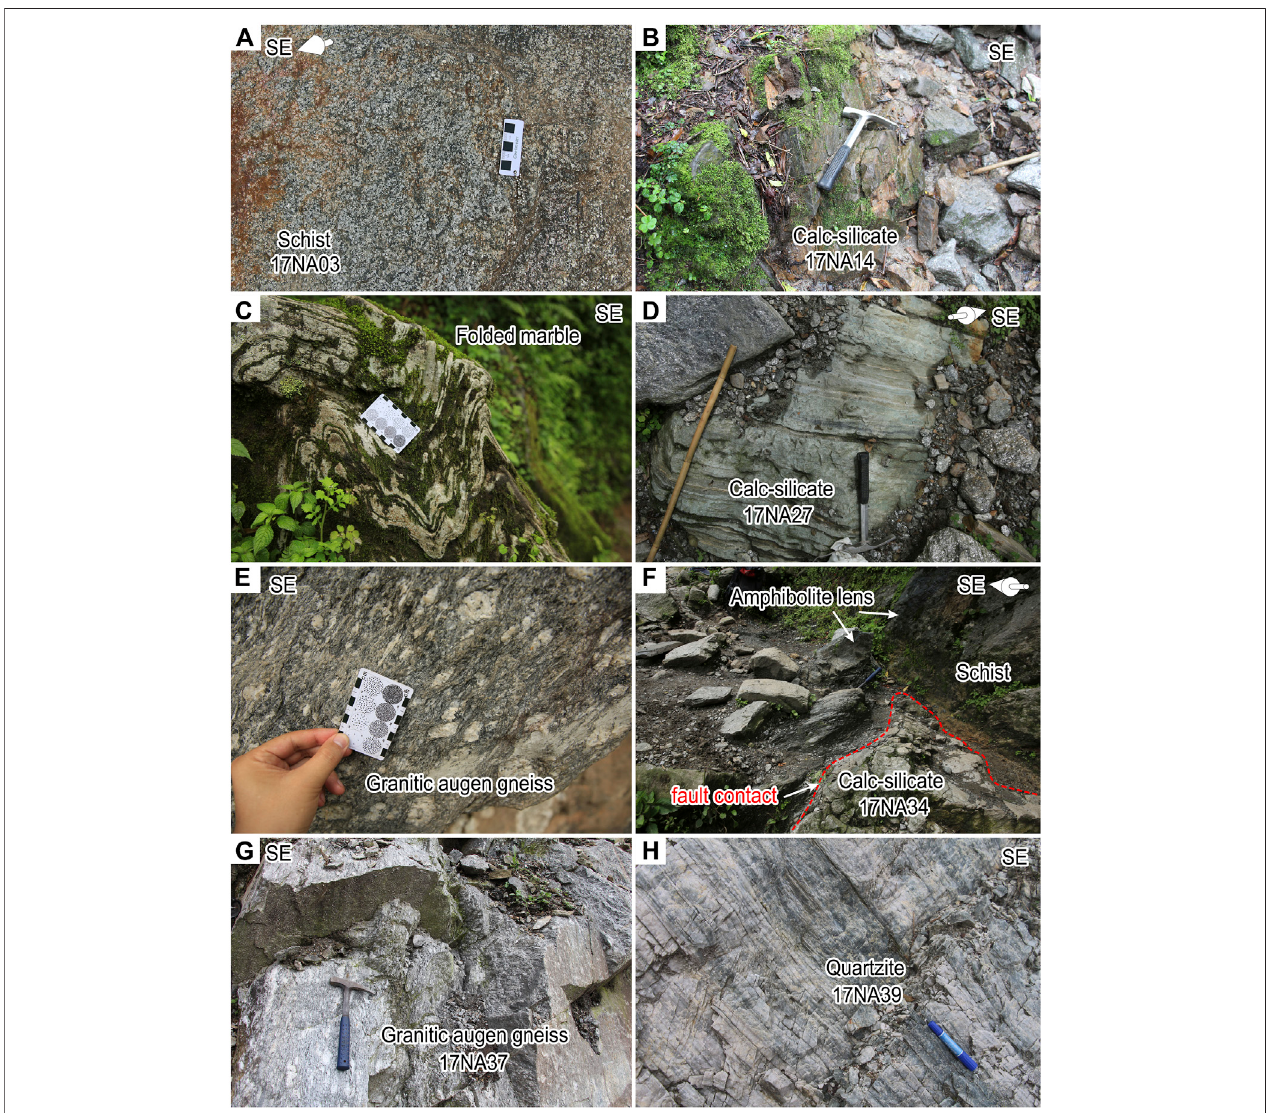
FIGURE3| Photographsoftheoutcrop. (A) Garnetschistbearssillimaniteandkyanite, (B) layeredcalc-silicaterockcontainstheintervalofmetapelites, (C) layered marbledeformsintotheintensivefold, (D) layeredcalc-silicaterockscontaintheintervalofmetapelites, (E) myloniteoforthogneisscontainsaugenoffeldspar, (F) garnet- schist has a faulted contact with crumpled calc-silicate rocks, (G) orthogneiss, and (H) layered quartzite.